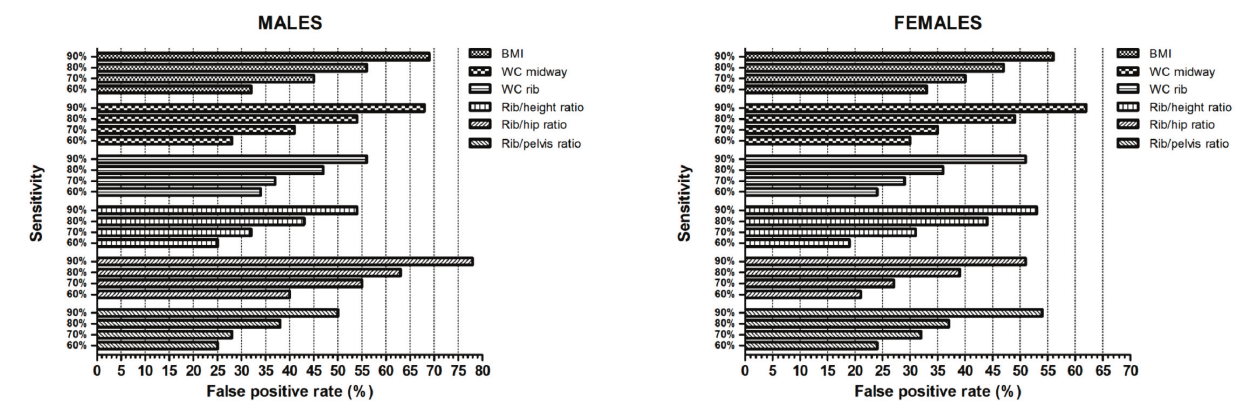
Fig 5. False positive rates corresponding to 90%, 80%, 70% and 60% sensitivities for selected obesity measures to classify subjects with type 2 diabetes. Results are stratified by gender and adjusted for age. Bars represent false positive rates